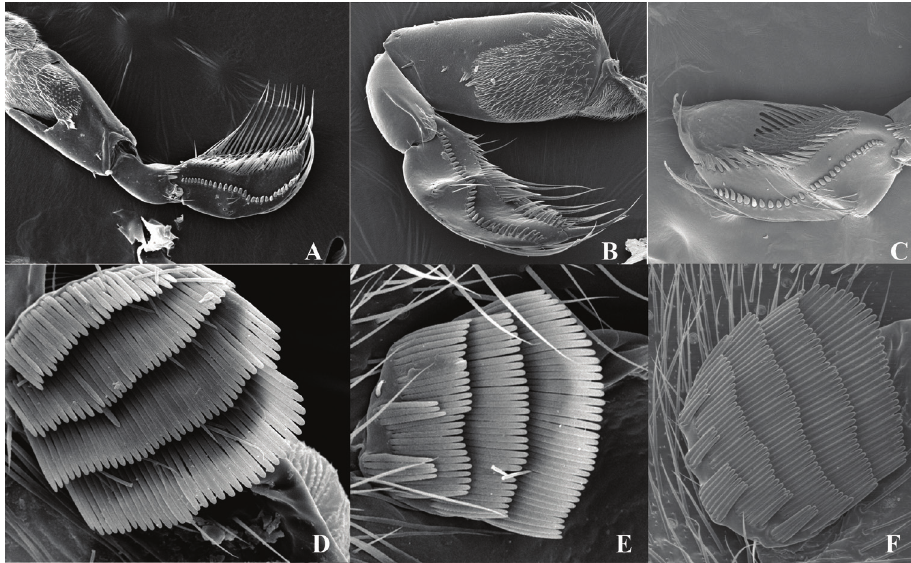
Figure 3. Male foreleg and strigil (Ren and Zhu 2010). A–D Cenocorixa bui B–E Cenocorixa crestiforma C–F Cenocorixa montana